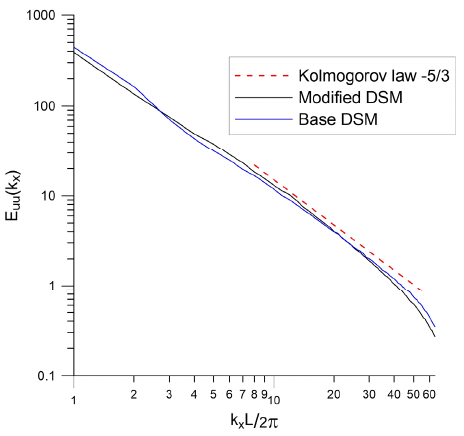
Figure 3. Longitudinal energy spectrum with and without modifications (14) to the